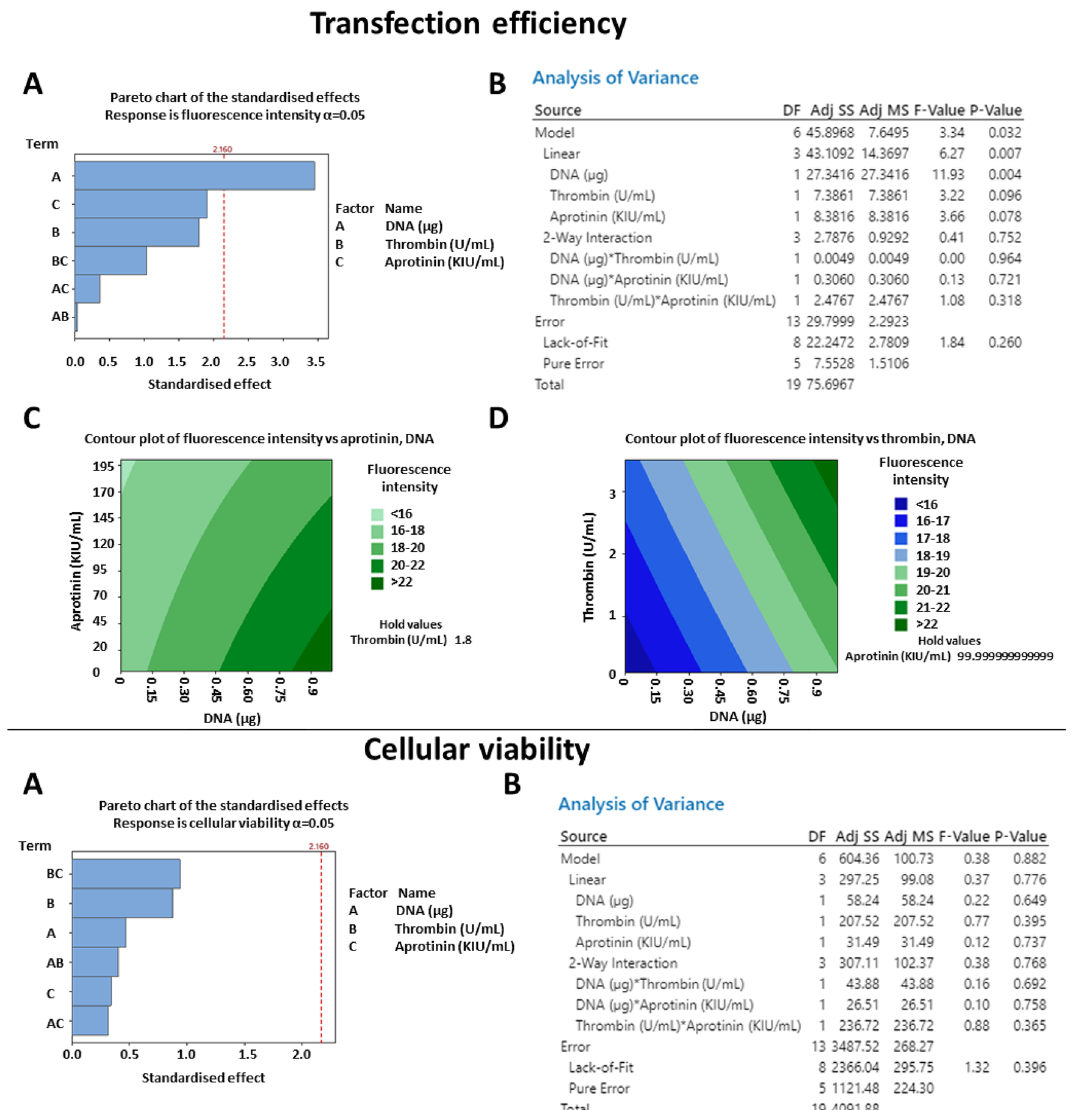
Figure 7. Characterisation of variables affecting transfection efficiency and cellular viability, through design of experiment. A response surface design was used to determine whether aprotinin, thrombin or DNA modulated transfection efficiency ( A – D ) and cellular viability ( E – F ). As shown in the Pareto chart ( A ) and in the ANOVA table ( B ), DNA concentration was the only factor significantly affecting transfection efficiency. Surface contour plots show how the mean fluorescence intensity per microscope field varied at different concentrations of DNA and aprotinin ( C ) or at different concentrations of DNA and thrombin ( D ). None of the variable tested significantly affected cellular variability ( E ), which did not significantly vary between the groups ( F ). N = 3. In A-D, five images were taken per group and the average values were analysed using fibroblasts. Some sparse green fluorescent dots were observed the day after conditioning (Fig. 9D). To confirm intra- cellular localisation, in some experiments, nuclei of live cells were counterstained with Hoechst 33,258 (Fig. 9E). These results indicated that the recombinant CTNS followed traditional exocytic and endocytic pathways.